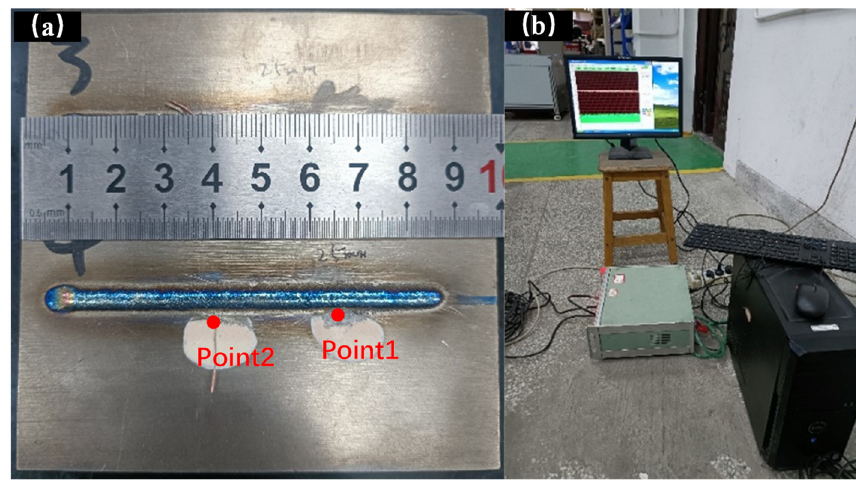
Figure 4. Thermocouple experiment equipment: ( a ) layout of the thermocouples; ( b ) image of the testing equipment.